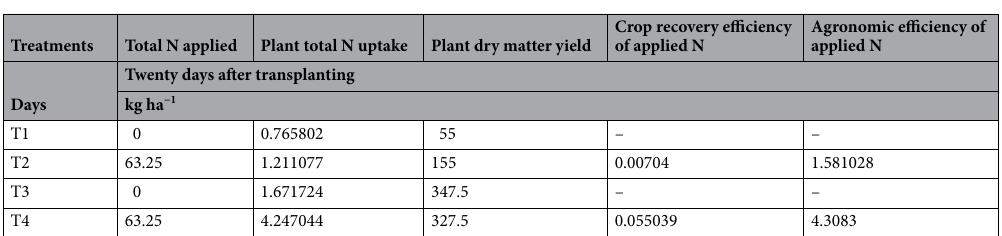
Table 15. Chicken litter biochar application and split application of urea on crop recovery and agronomic efficiency on day twenty after transplanting.